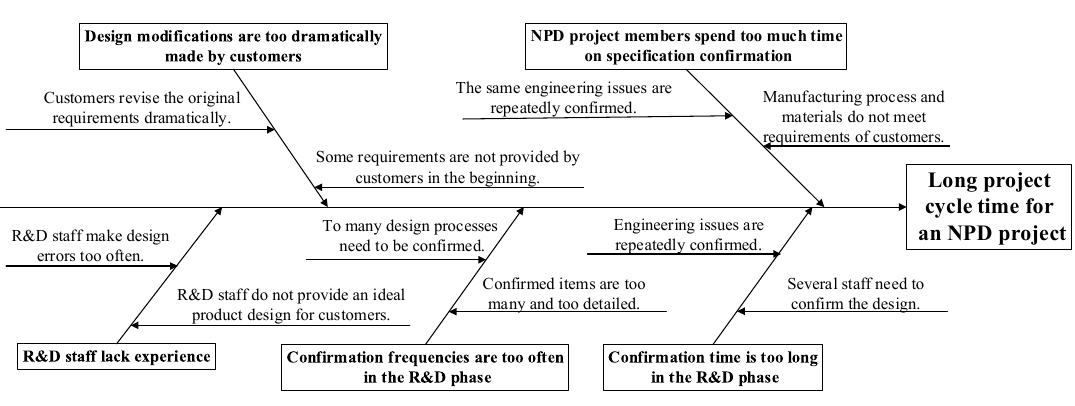
Figure 7. Cause-and-effect chart of the PCB R&D process.